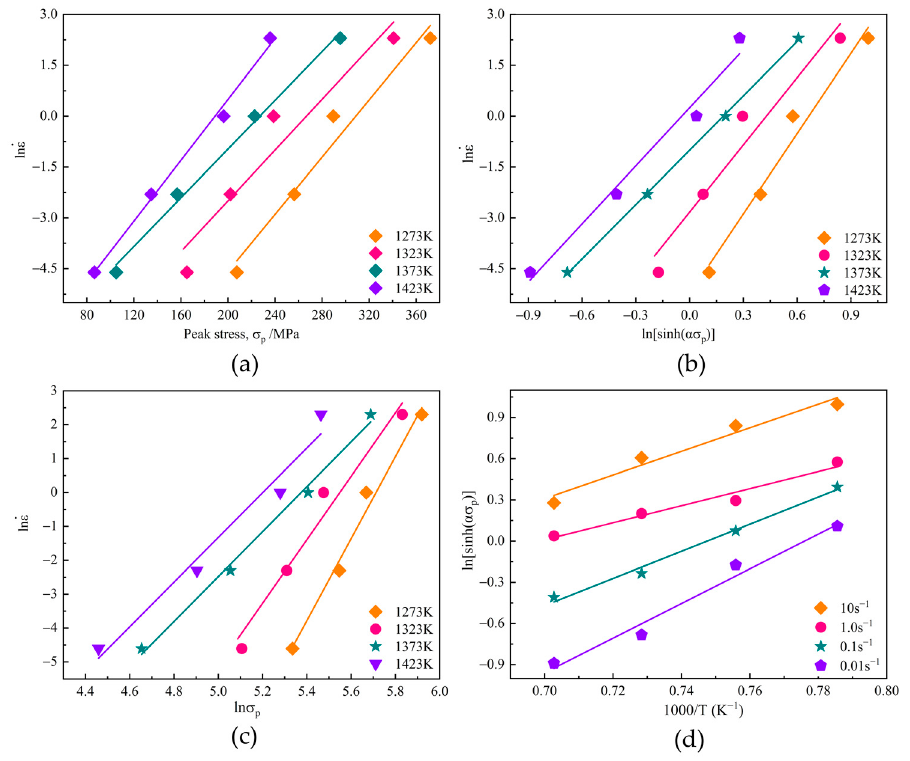
Figure 7. All of the plots used for determining the parameters of the constitutive equation: ( a ) ln vs. σ p ; ( b ) ln vs. ln σ p ; ( c ) ln vs. ln [ sinh ( ασ p )] ; ( d ) ln [ sinh ( ασ p )] vs. 1000/T.